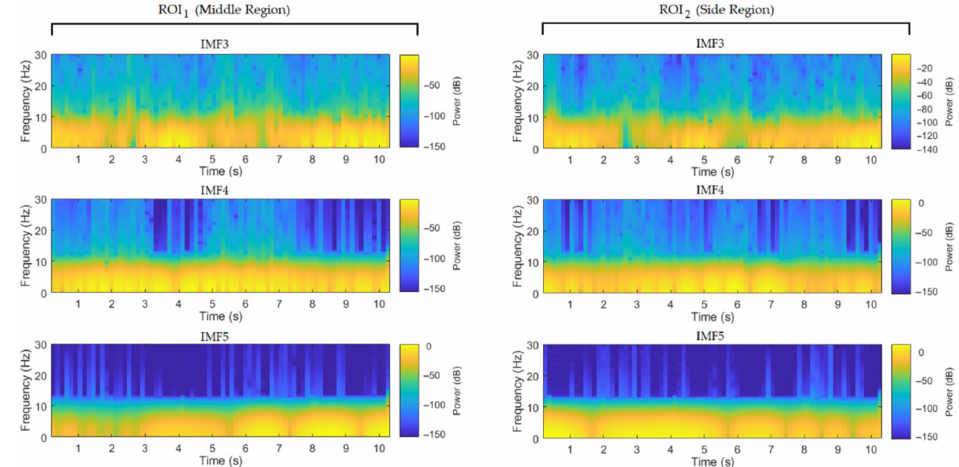
Figure 5. The selected IMF spectrums from ROI 1 and ROI 2 at a time resolution of 0.5